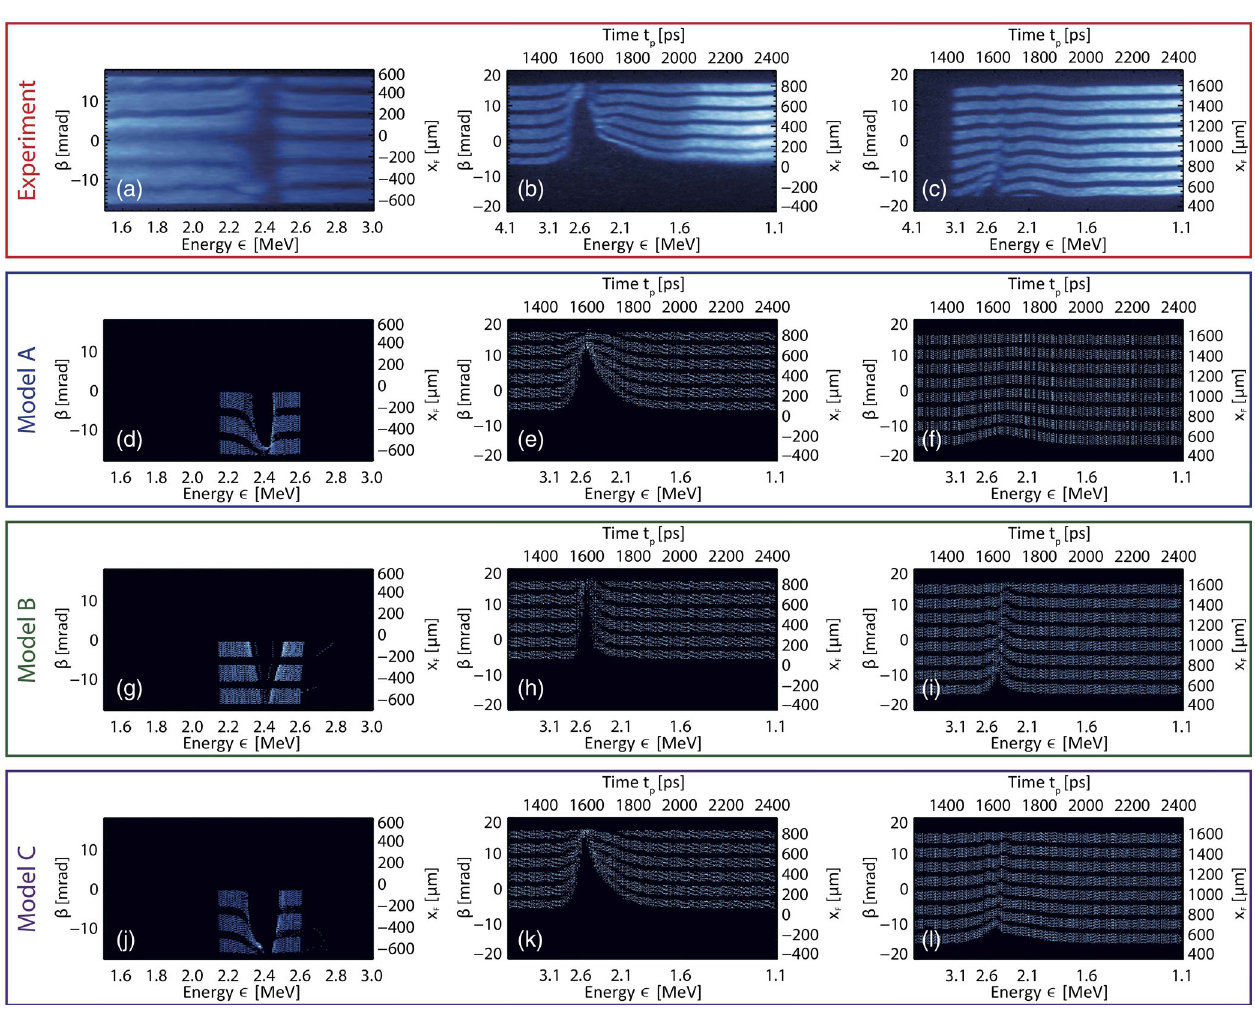
FIG. 8. Experimental [(a) – (c)] and simulated [(d) – (l)] streak deflections in longitudinal [(a), (d), (g), (j)] and transversal [(b), (c), (e), (f), (h), (i), (k), (l)] imaging